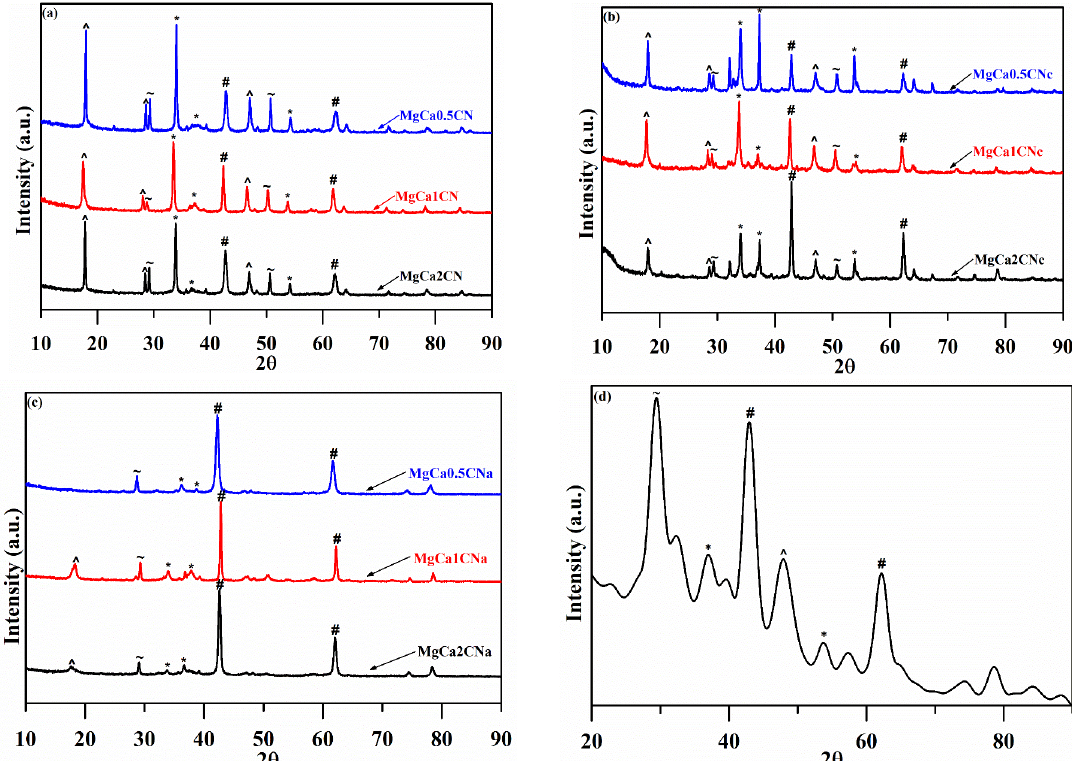
Figure 2. Powder X ‐ ray diffraction patterns of CaO–MgO synthesized using ( a ) Na 2 CO 3 , ( b ) Figure 2. Powder X-ray diffraction patterns of CaO–MgO synthesized using ( a ) Na 2 CO 3 , ( b ) Na 2 CO 3 , Na 2 CO 3 , and ( c ) NaOH as precipitants, calcined at 700 °C with different Mg/Ca ratios. ( d ) XRD and ( c ) NaOH as precipitants, calcined at 700 ◦ C with different Mg/Ca ratios. ( d ) XRD patterns of patterns of the spent catalyst (^: Ca(OH) 2 , ~: CaCO 3 , #: MgO, and *: CaO). the spent catalyst (ˆ: Ca(OH) 2 , ~: CaCO 3 , #: MgO, and *: CaO).